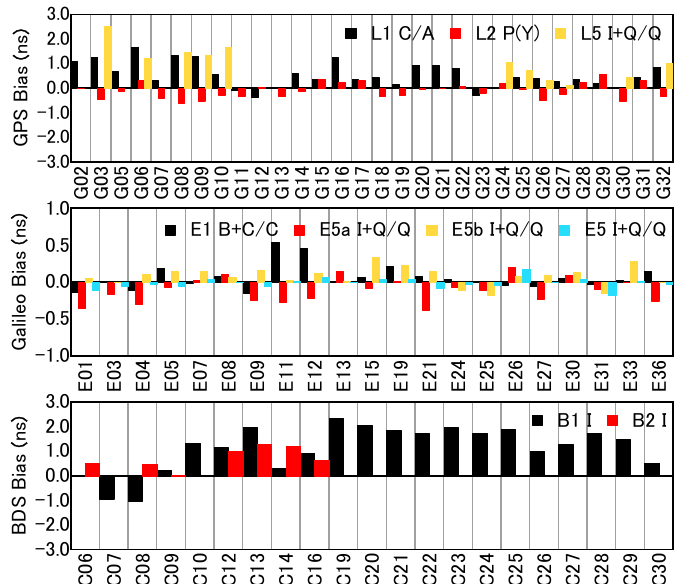
Figure 4. Receiver-related pseudorange biases of baseline MAR6_MAR7 for GPS ( top ), Galileo ( middle ) and BDS ( bottom ). This baseline equipped with SEPTENTRIO and TRIMBLE receivers.